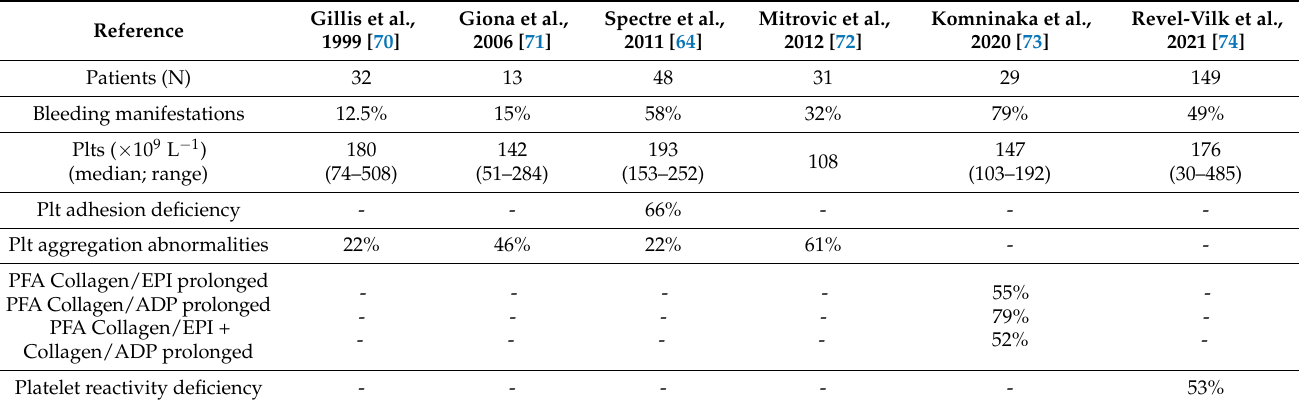
Table 2. Studies of platelet abnormalities in Gaucher disease before start ERT/SRT: percentage of patients in each study found to have bleeding and platelet function